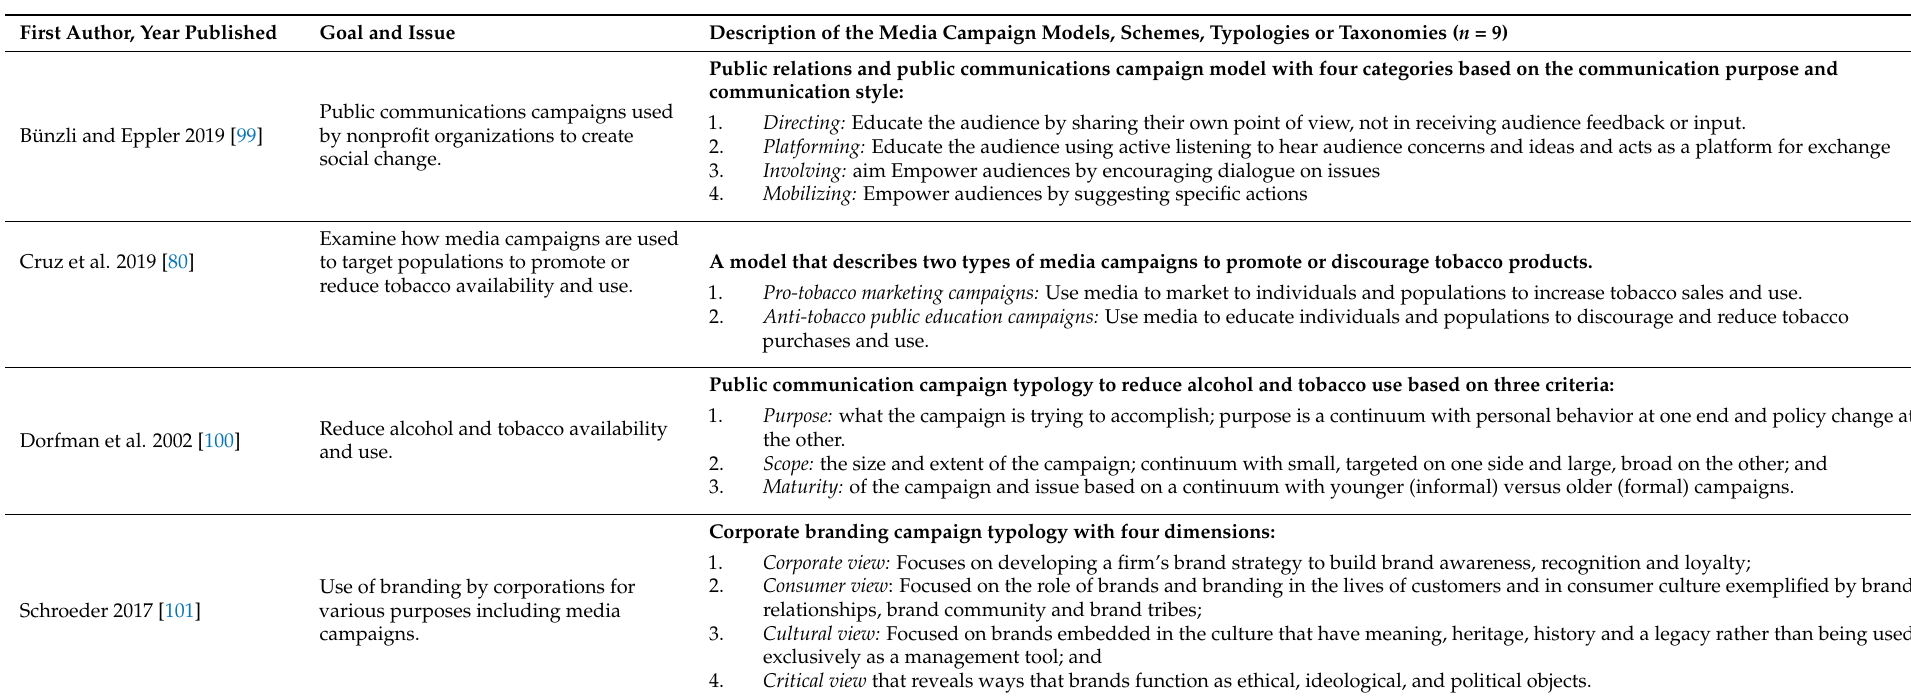
Table 3. Evidence from the scoping review of unique media campaign models, schemes, typologies or taxonomies,